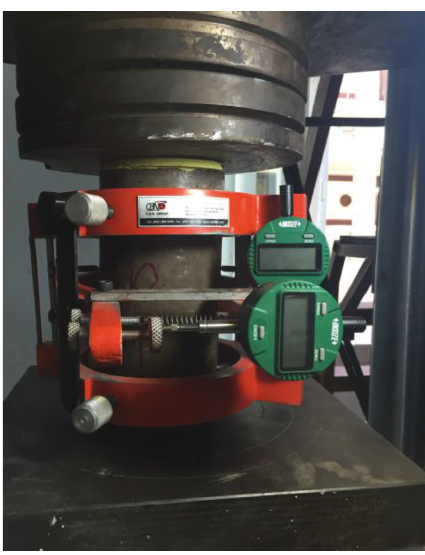
Figure 3: Test setup for compressive strength, modulus of elas- ticity, and Poisson’s ratio.